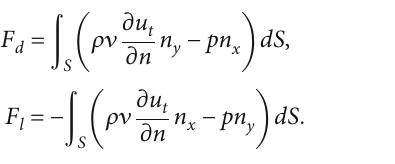
= 0 : 2 and Re = 20 . (a) Bn = 10 : (b) Bn = 50 p